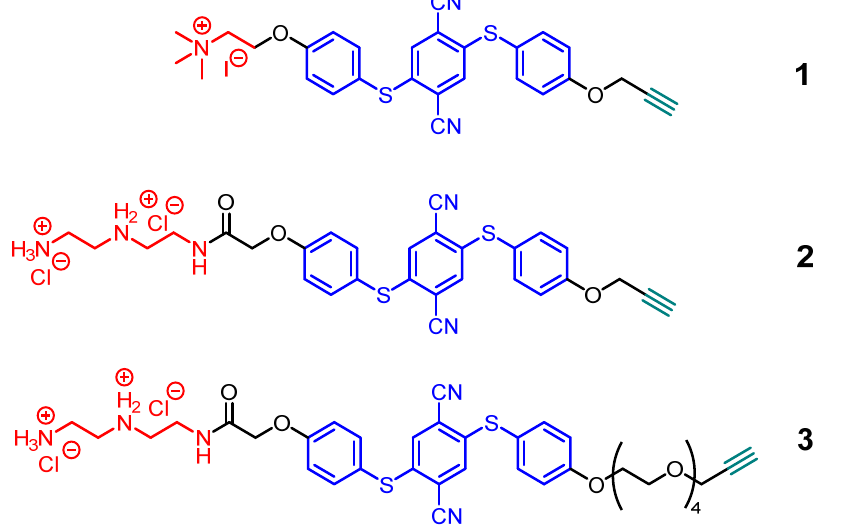
Figure 1. Molecular structures of the AIE ligands 1 to 3 that were covalently attached to ultrasmall gold nanoparticles.